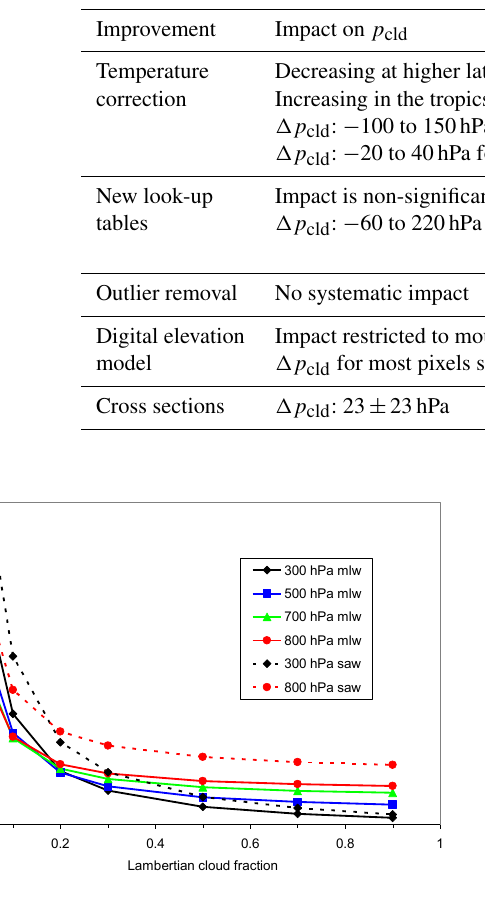
Figure 3. Bias in the retrieved pressure ( p retr − p true ) in hPa when in the retrieval a mid-latitude summer temperature profile is used, whereas in the simulation a mid-latitude winter profile (mlw) or a subarctic winter profile (saw) is used. The results are plotted as a function of the cloud fraction and for different pressure levels of the cloud used in the simulation. The surface albedo is fixed at 0.05, the cloud albedo is 0.80, the solar zenith angle is 60 ◦ and the viewing direction is